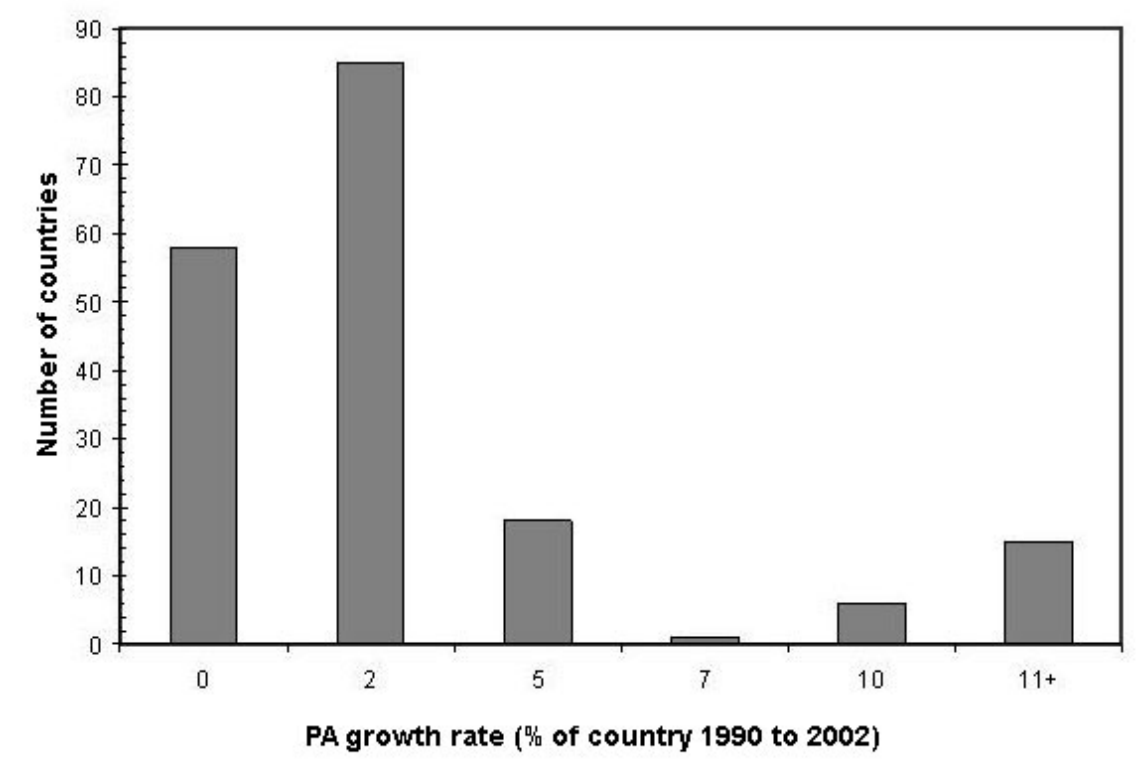
Fig. 2. Frequency distribution of protected area growth rates for the period